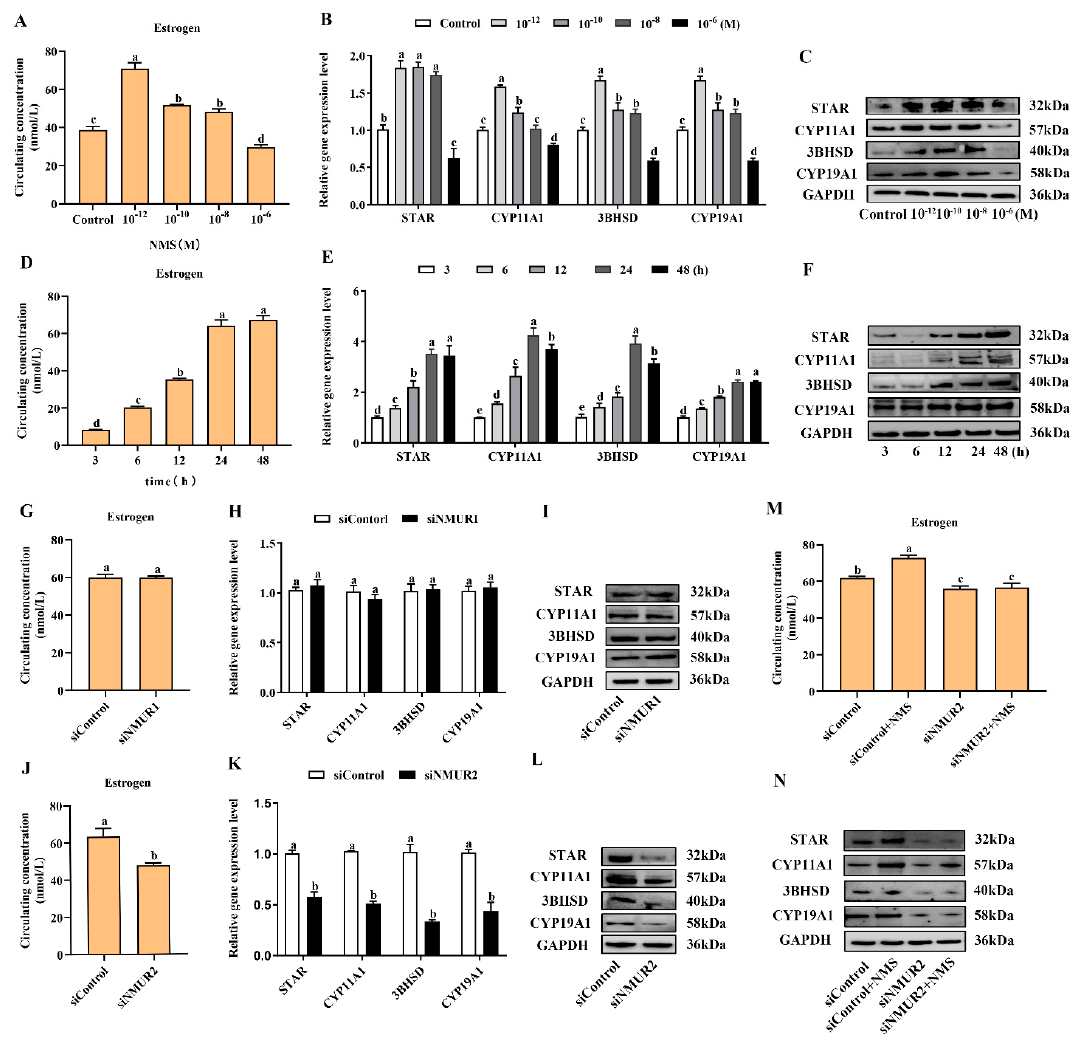
Figure 3. Effects of NMS treatment and knockdown of NMUR2 on steroid hormone synthesis in goat granulosa cells. ( A ) The level of estrogen secretion under NMS treatment at different concentrations (10 − 12 , 10 − 10 , 10 − 8 and 10 − 6 M) in goat GCs. ( B ) The mRNA expressions of STAR, CYP11A1, 3BHSD, and CYP19A1 under NMS treatment at different concentrations were detected by qPCR. ( C ) The protein expressions of STAR, CYP11A1, 3BHSD, and CYP19A1 under NMS treatment at different concentrations were detected by Western blot. ( D ) The level of estrogen secretion under NMS (10 − 12 M) treatment for different treatment times (3, 6, 12, 24 and 48 h) in goat GCs. ( E ) The mRNA expressions of STAR, CYP11A1, 3BHSD, and CYP19A1 under NMS (10 − 12 M) treatment at different treatment times were detected by qPCR. ( F ) The protein expression of STAR, CYP11A1, 3BHSD, and CYP19A1 under NMS (10 − 12 M) treatment at different treatment times by Western blot. ( G ) The effect of siNMUR1 treatment on estrogen secretion level. ( H ) The effect of siNMUR1 treatment on STAR, CYP11A1, 3BHSD, and CYP19A1 mRNA expression. ( I ) The effect of siNMUR1 treatment on STAR, CYP11A1, 3BHSD, and CYP19A1 protein expression. ( J ) The effect of siNMUR2 treatment on estrogen secretion level. ( K ) The effect of siNMUR2 treatment on STAR, CYP11A1, 3BHSD and CYP19A1 mRNA expression. ( L ) The effect of siNMUR2 treatment on STAR, CYP11A1, 3BHSD and CYP19A1 protein expression. ( M ) The effect of siNMUR2 and NMS cotreatment on estrogen secretion. ( N ) The effect of siNMUR2 and NMS cotreatment on STAR, CYP11A1, 3BHSD, and CYP19A1 protein expression. Data are expressed as fold change and are presented as mean ± S.E.M. of the results obtained in at least three independent experiments. Different letters indicate significant differences in the expressions between the groups ( p <